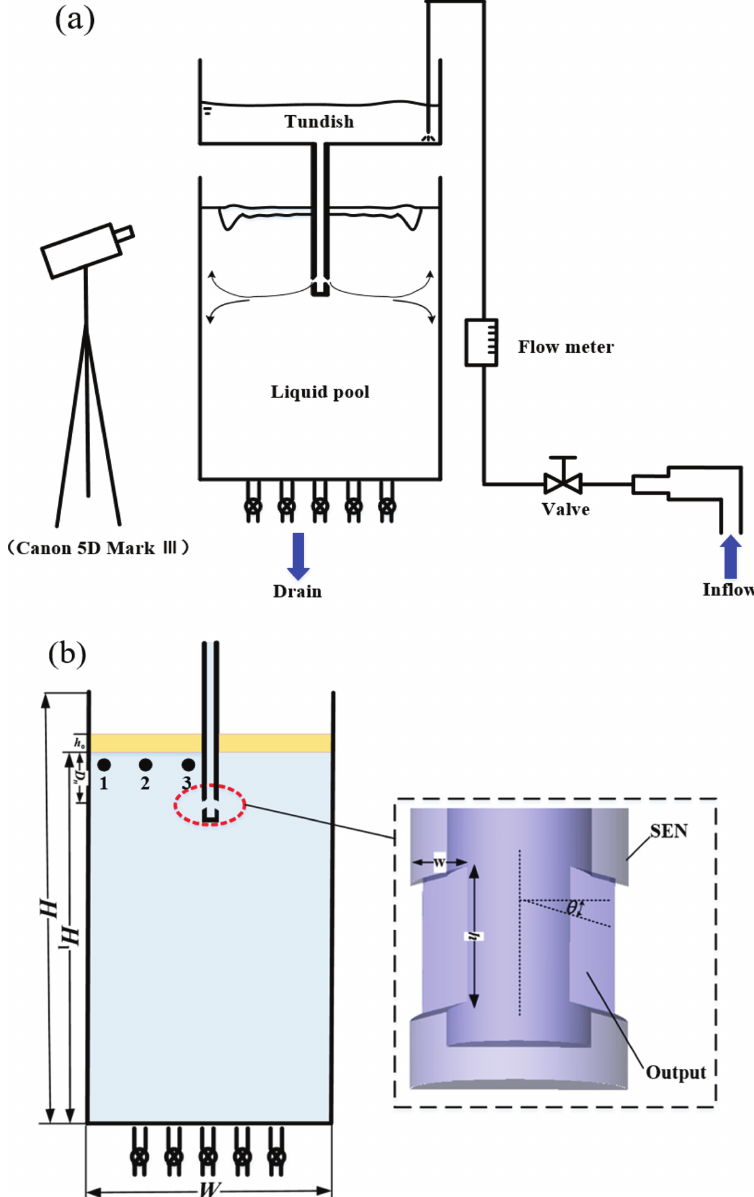
Figure 2: Schematic diagrams of (a) experimental equipment and (b) measuring points, geometries of water model and